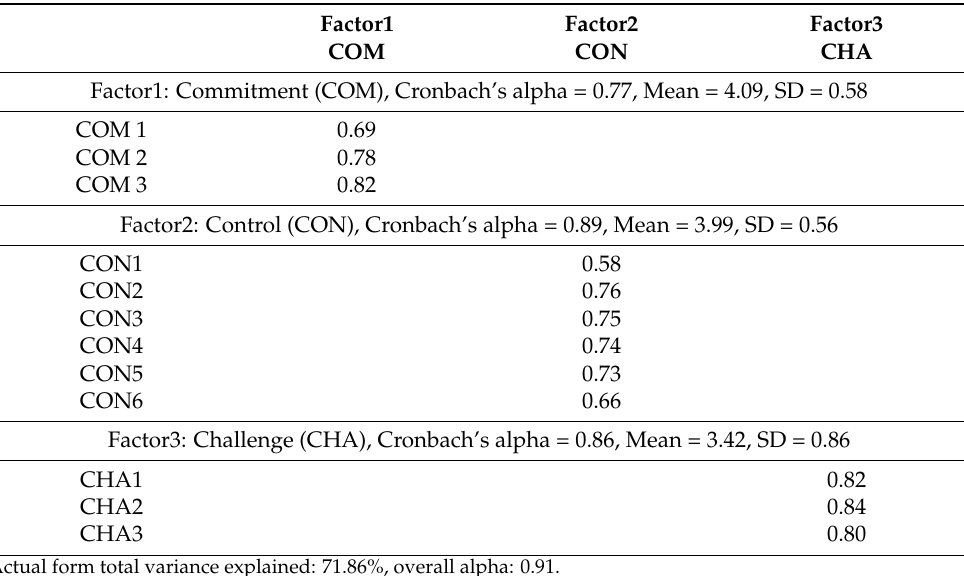
Table 2 contained the final 12-item, 3-factor scale. Table 2. Results of EFA for WRH ( N =